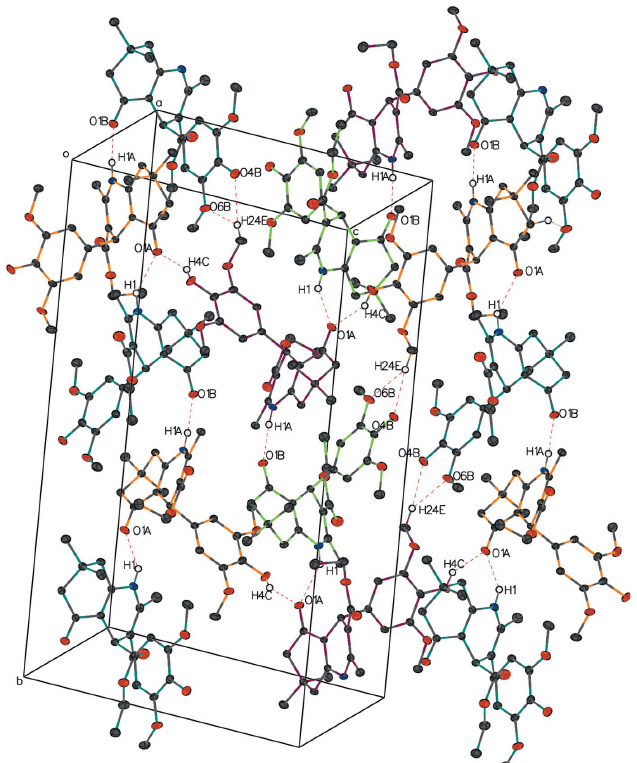
Figure 7 The packing of compound II showing an array of columns along the b axis formed by hydrogen bonds. Atoms involved in hydrogen bonds are labeled. H atoms not involved in hydrogen bonds are omitted for clarity. Molecules A and B are colored in orange and lime, respectively. Molecules colored in magenta are the enantiomers of molecule A , and those colored in teal are the enantiomers of molecule B .